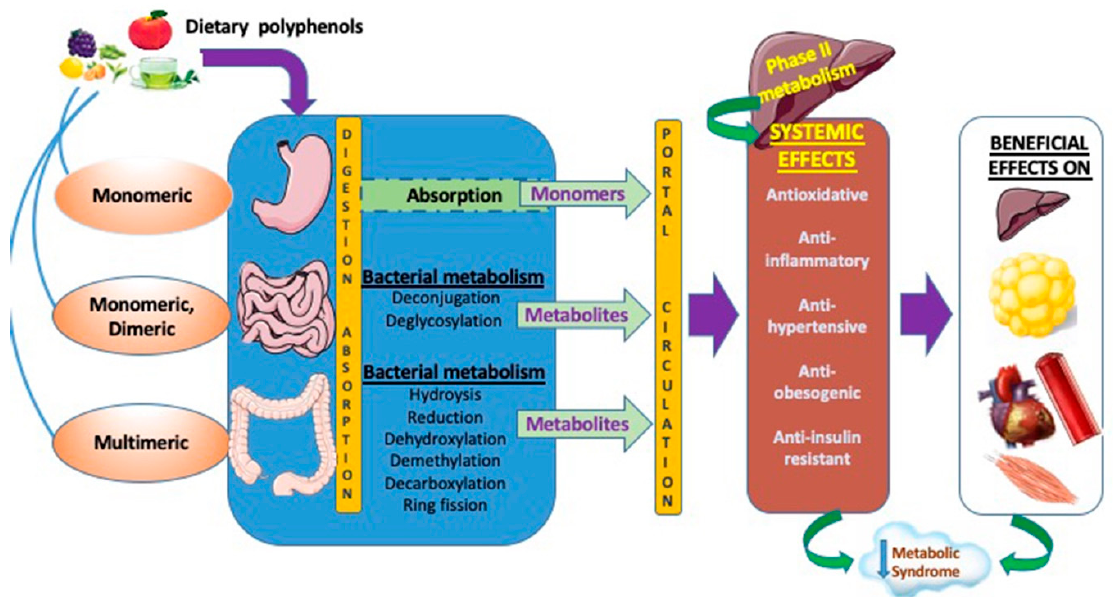
Figure 1. Integrated view of intestinal dietary polyphenol absorption, luminal transformation, and actions of their relevant metabolites on cardiometabolic disorders. As dietary polyphenols have limited absorption in the stomach and the small intestine, the unabsorbed polyphenols continue their transit to the colon where they are hydrolyzed, demethylated, decarboxylated, dehydroxylated, and ring fissioned by microbiota. Following these processes, microbial metabolites are subjected to phase II metabolism in the colon and liver, and enter the bloodstream to exert their biological effects, which extend to peripheral organs. Unabsorbed polyphenols and metabolites are excreted in feces, and